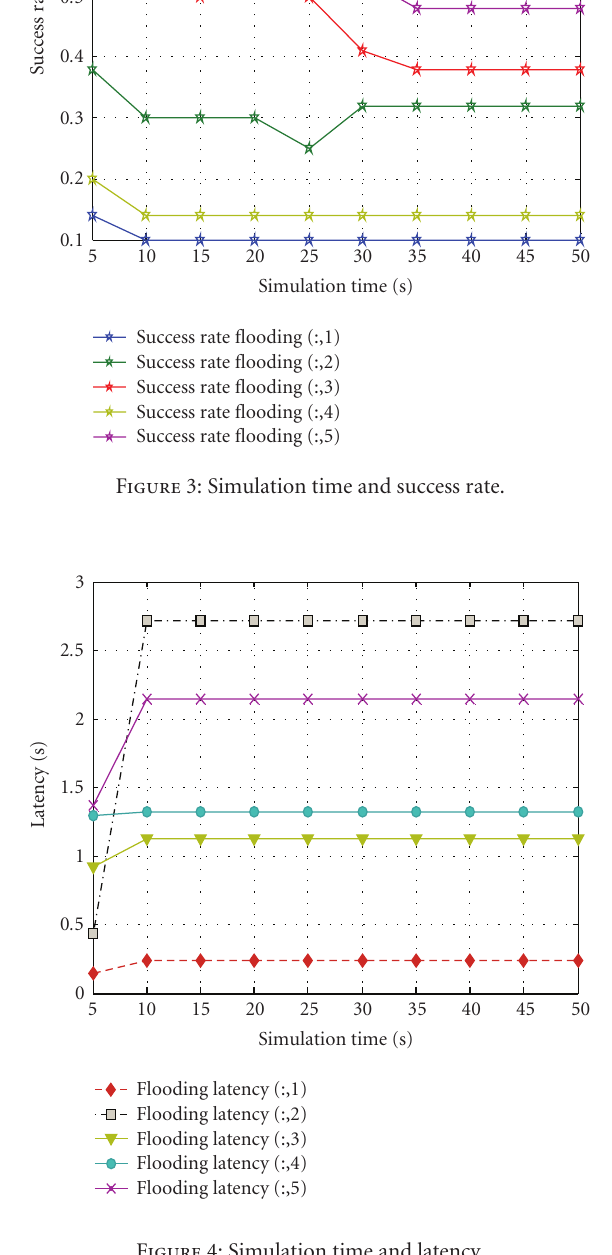
Figure 4: Simulation time and latency. rates in a prowler simulator. We randomly place 100 sensor nodes in a 100 m × 100 m sensor field for each protocol. The default prowler radio model is used. Each routing protocol test is performed (with query and event locations randomly selected) which, started by one packet and then increased the number of packets. In this section, performances of the selected routing protocols with increased workload are evaluated as